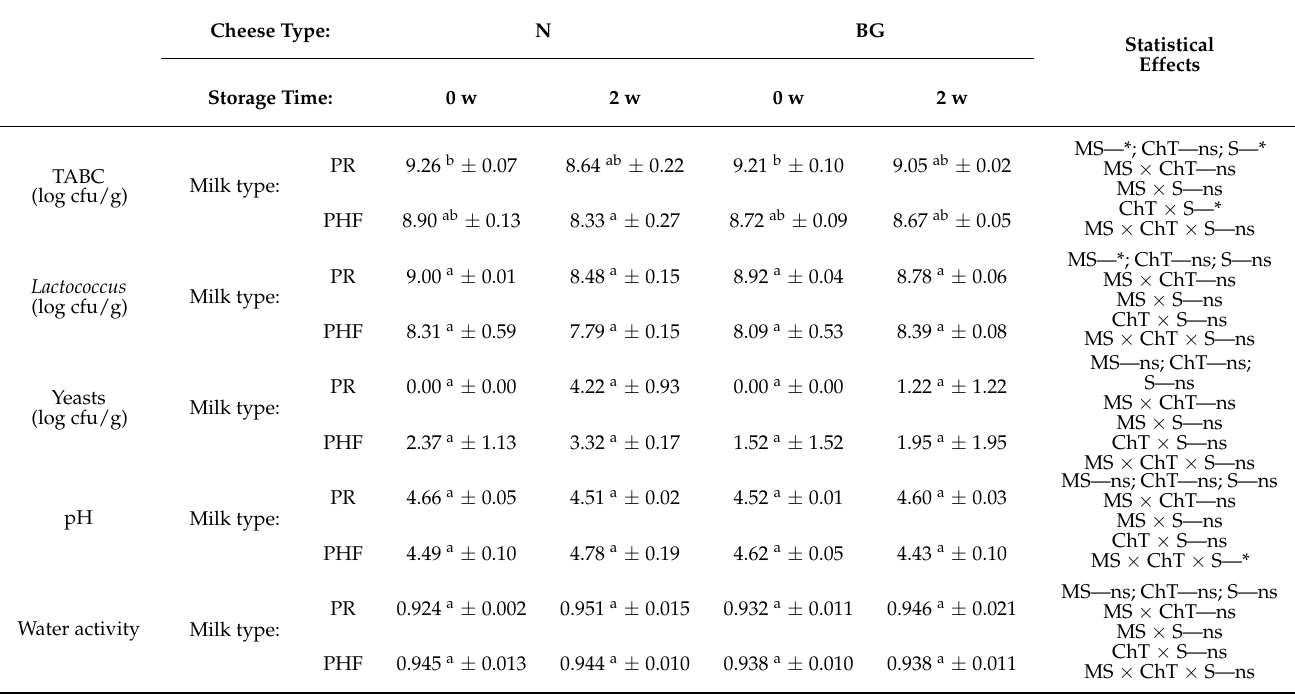
Table 4. Microbiological quality of the analyzed cheeses (average ±